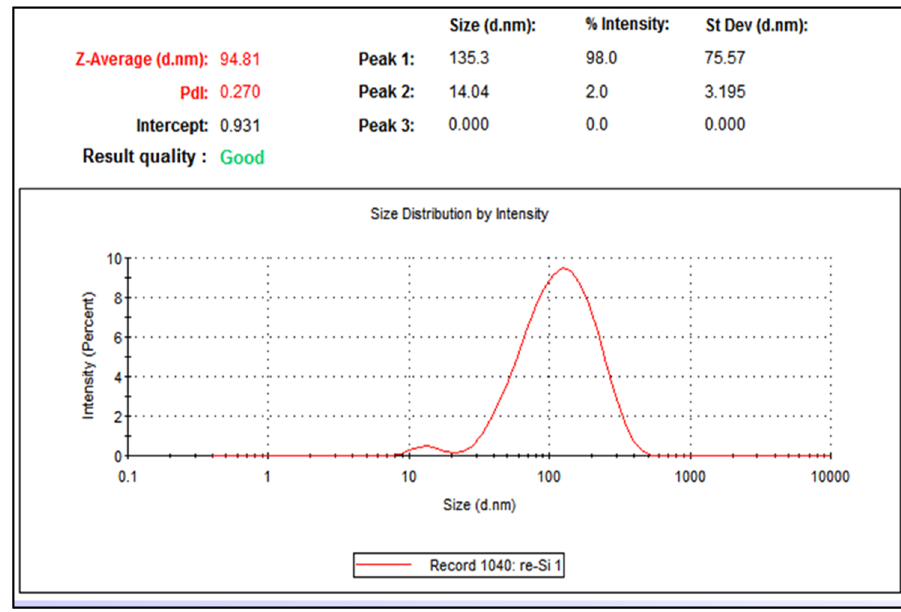
Figure 4: DLS spectrum showing the average hydro - dynamic size of synthesized Si -